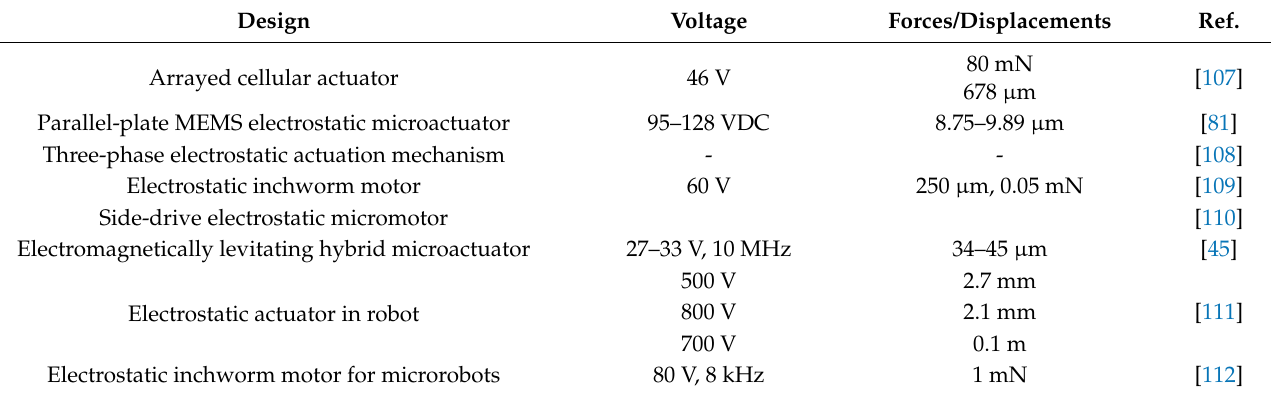
Figure 16. Inchworm motor: ( a ) concept; ( b ) the proposed AUC for the cooperative microactuator system, h—unit cell height, w w —width of the cell wall, s—stroke, V 0 —actuation voltage, w s —stopper width, l e —stationary electrodes length, l s,y —spam beam length of y-axis spring, l e,y —extension beam length of y-axis spring, l c,y —connector beam length of y-axis spring, l e,x —extension beam length of x-axis spring, l c,x —connector beam length of x-axis spring. Adapted from [106]. Table 7. Electrostatic actuators in micromotors reported in the last 5 years.